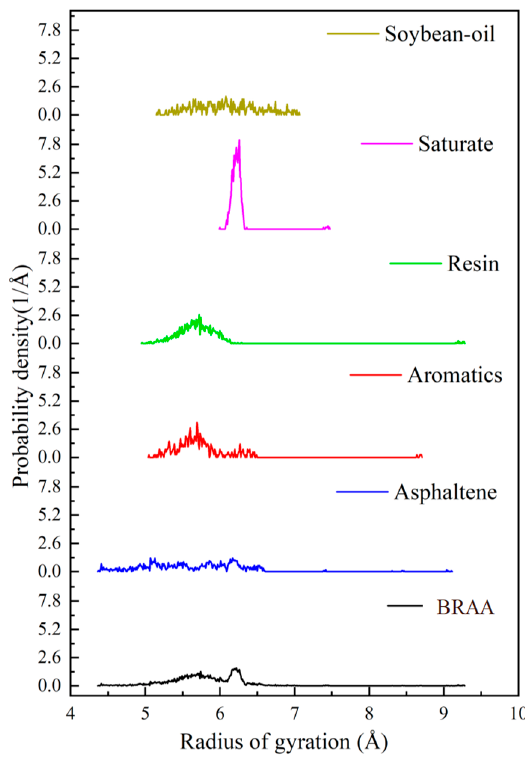
Figure 7. Radius of gyration results.